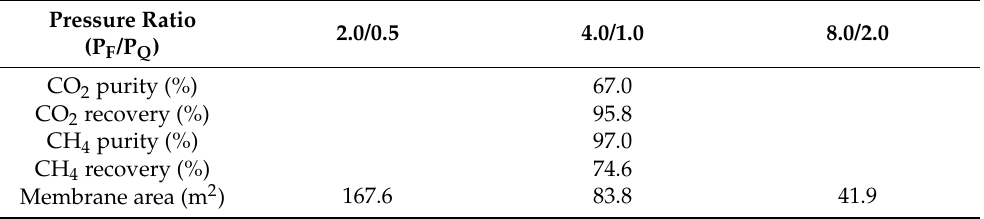
Table 2. Process performance parameters of the IL2 membrane under different pressure conditions (1 m 3 /h (STP) feed stream with CO 2 /CH 4 composition =